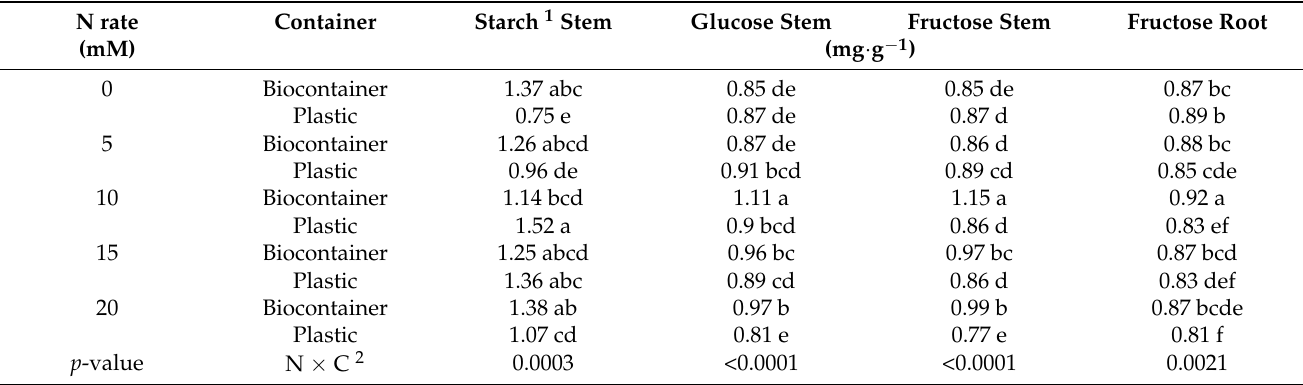
Table 4. Carbohydrate concentrations in Encore ® azalea ‘Chiffon’ affected by the N rate and container type